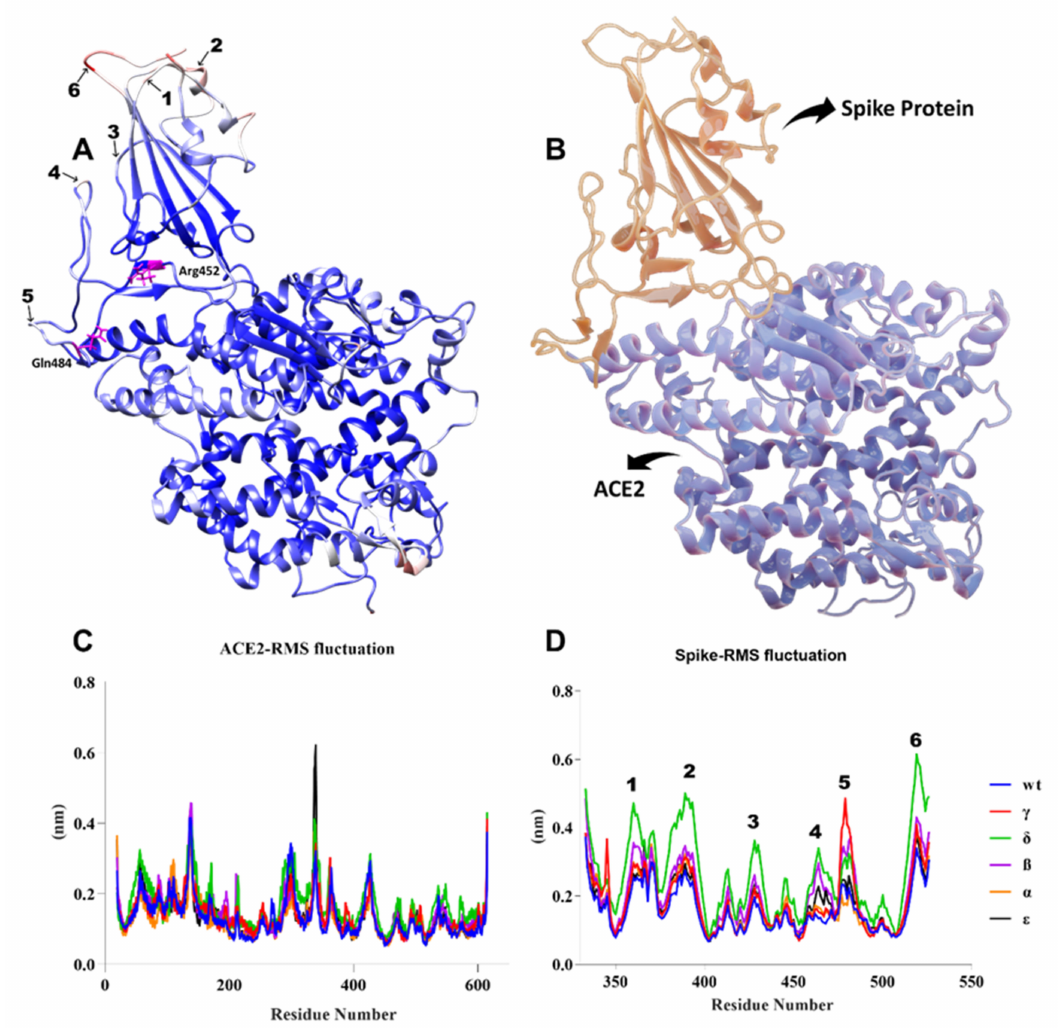
Figure 10. ( A ) B-factor representation of delta variant S-hACE2 complex residues during 100-ns MD simulation (red represents high fluctuations and blue represents low fluctuations). Mutant residues are indicated in pink. ( B ) S-protein interaction with hACE2 receptor (red represents S protein and blue represents ACE2 receptor). ( C , D ) RMSF of ACE2 and S residues throughout the 100-ns MD